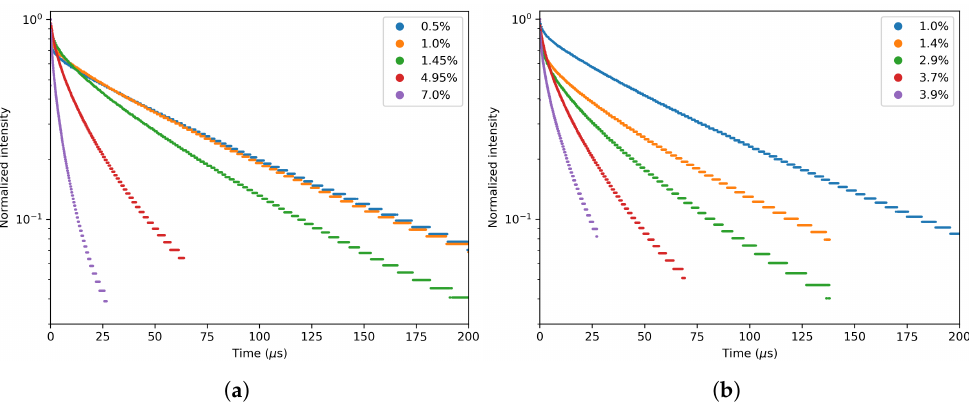
Figure 14. Decay measurement of ( a ) the GA series and ( b ) the GV series. The decay times fitted through these graphs can be found in Table 3. The concentrations are those found in the EDX measurements except for the 0.5% and 1% samples.